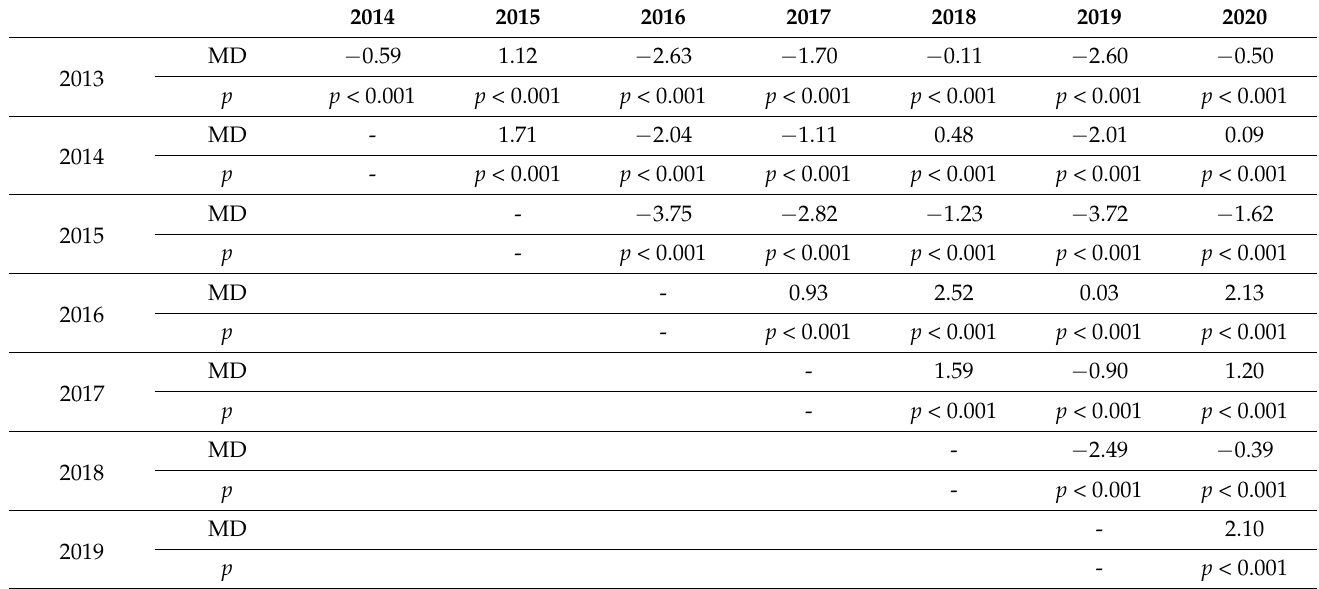
Table 12. Comparison of the use of ventilation with oxygen between individual editions of the Championships.